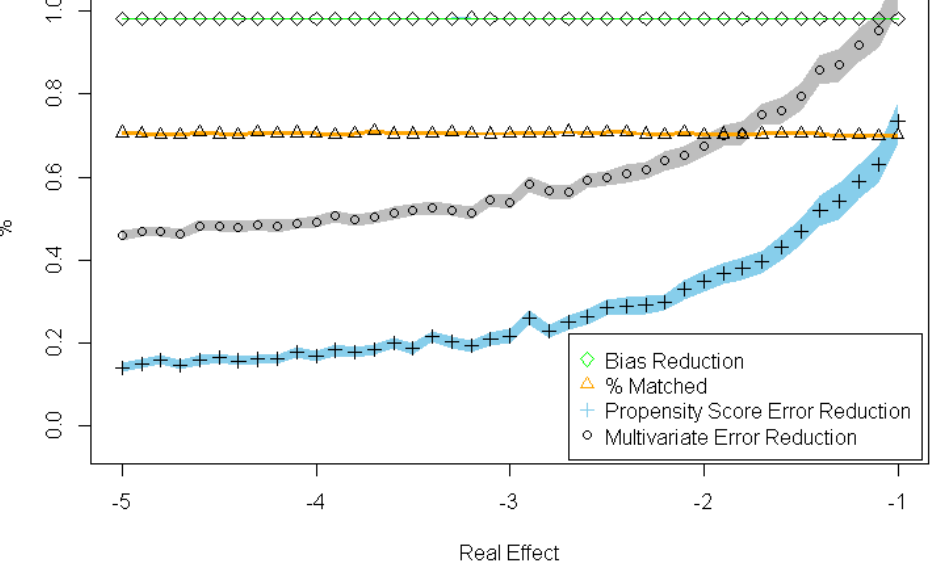
Figure 1. Comparison of the Real Treatment Effect Estimation Reduction with the Multivariate Model and the Propensity Score Matching Model. Table 1. Treatment Selection Bias for the Unadjusted Model and the Propensity Score Matching